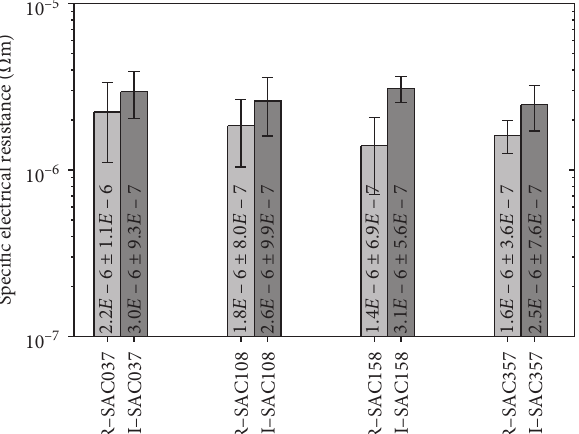
Figure 7: Electrical resistivity of soldered joints: prefixes R, reflow soldered by hot plate and I, soldered by induction heating.